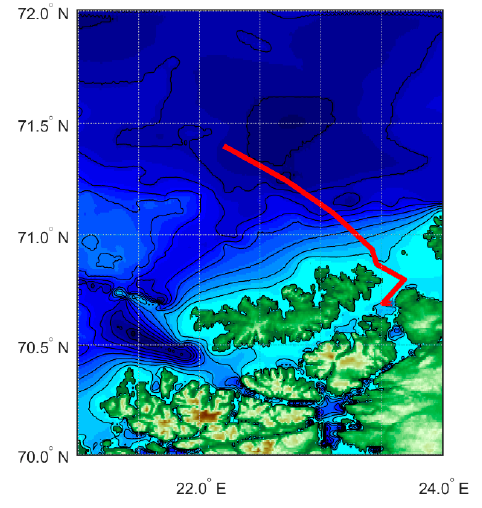
Figure 7. Approximate Melkøya CO2 Pipeline Route.